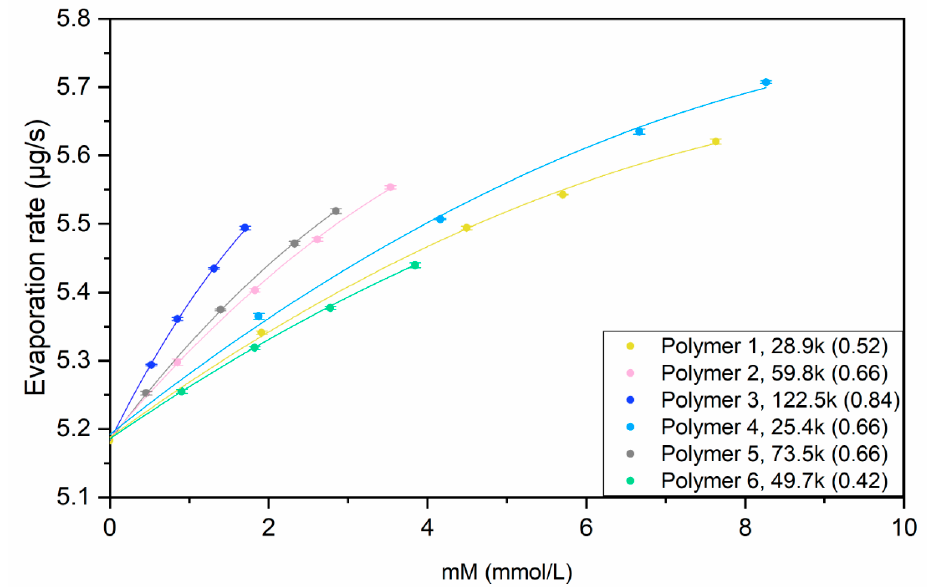
Figure 6. Evaporation rate of Polymer 1–6 solutions at various mM.